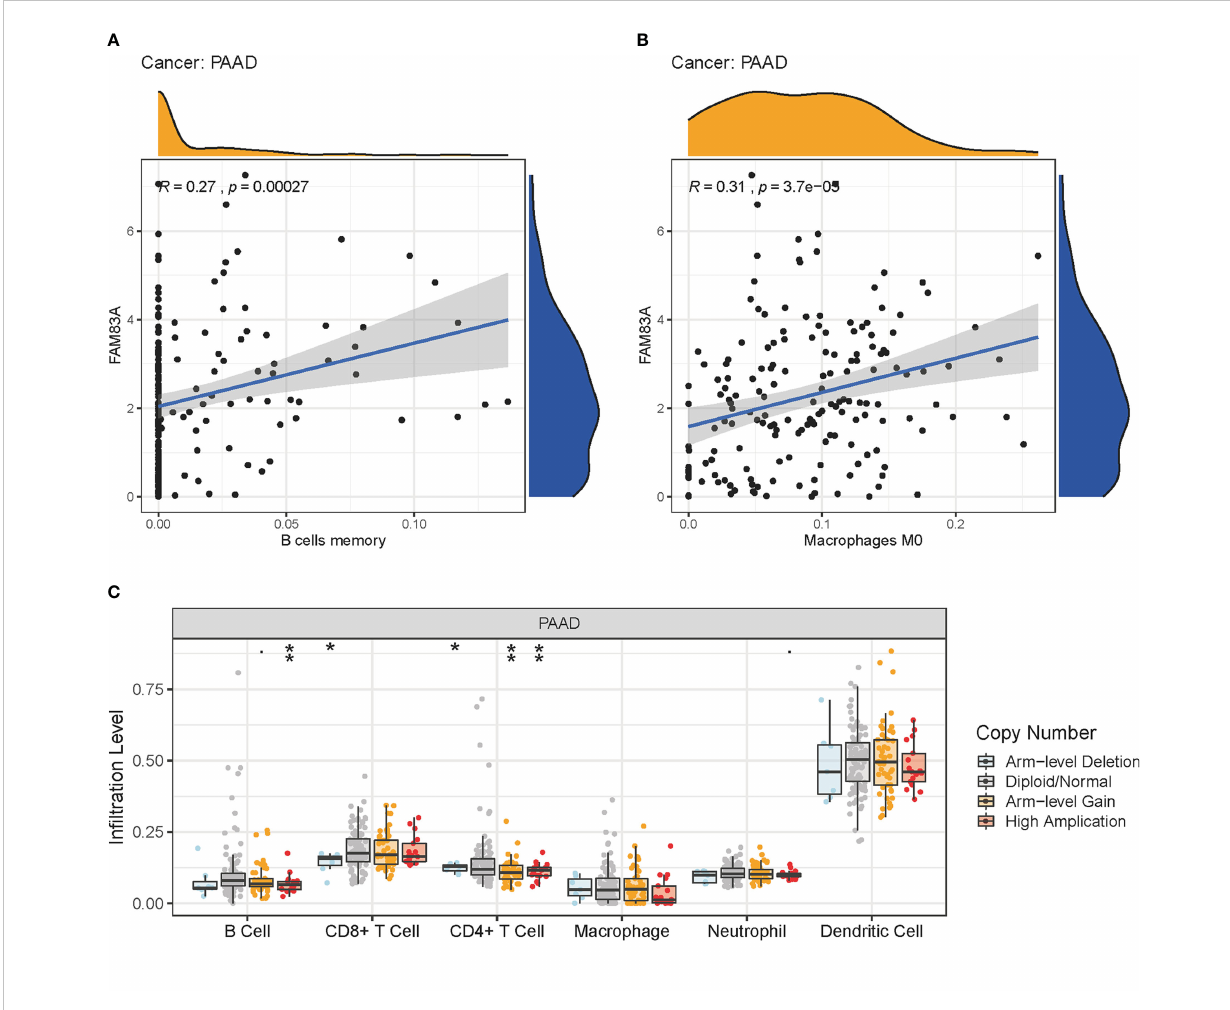
FIGURE 6 Immune cell in fi ltration (ICI) analysis: (A-B) The relationship of FAM83A expression with ICI in PC. (A) Memory B cells. (B) Macrophages M0. (C) ICI level under copy numbers variation of FAM83A in PC. *p value < 0.05; **p value <